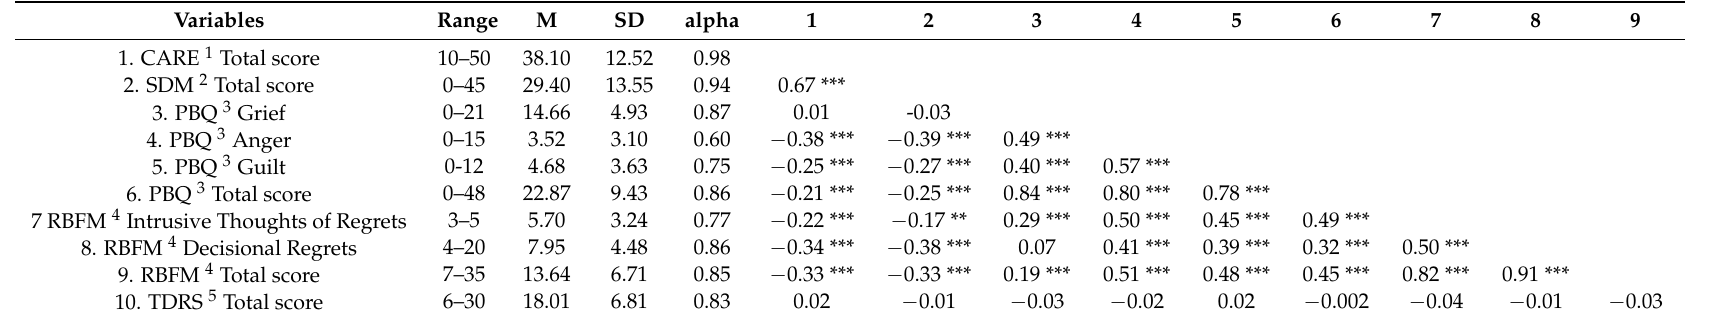
Table 2. Descriptive statistics (Range, Mean, Standard Deviation, Cronbach’s alpha) and correlations for study variables